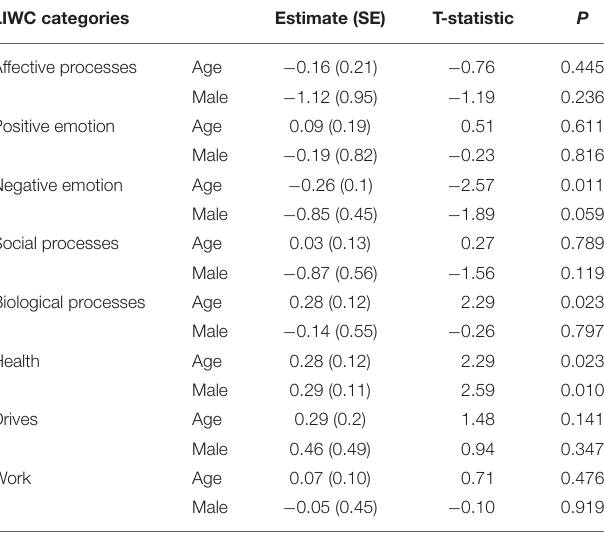
TABLE 1 | Odds ratios (OR) and confidence intervals (CI) from logistic regression models for comments coded in different content categories. Content categories